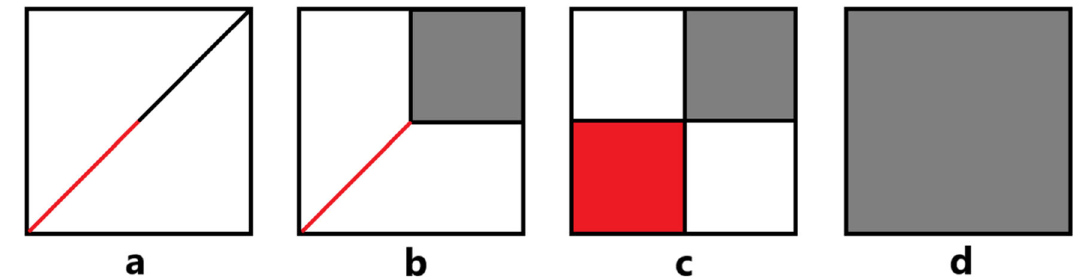
Fig. 5 | Diagrams of four different types of x DC - x IP maps. Red/gray denote basis functions that can/cannot be removed. From left to right: a high correlation between x DC and x IP , basis set can be truncated at any accuracy (e.g., H 2 dimer 6- 31G**,pulse z direction); b highcorrelationbetween x DC and x IP untilcertain s (where s is boundary of high and low correlation regions), basis set can be truncated at